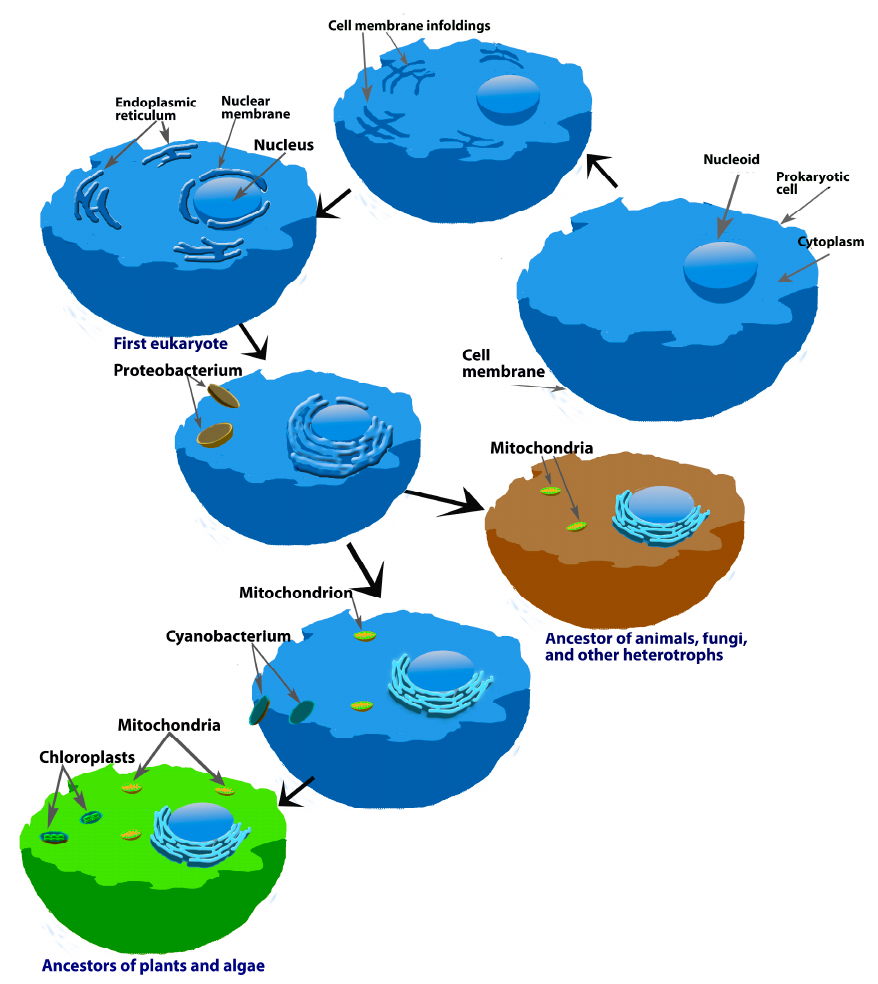
Figure 5. This is an illustration of what is referred to as the endosymbiotic theory for the origin of mitochondria (and chloroplasts) and why these organelles in present-day eukaryotes likely have the ability to produce melatonin. A couple of billion years ago, prokaryotes phagocytized proteobacteria, which are known to synthesize melatonin; these bacteria were initially digested and used as nutrition. During evolution, the ingested bacteria eventually developed a mutually-beneficial symbiotic relationship with the cells that ingested them and they evolved into mitochondria. When they did so, the evolved mitochondria retained the ability to produce melatonin (brown image). As a result, present-day eukaryotic cells synthesize melatonin as shown in several reports cited in the current review. Likewise, some of the same prokaryotes also engulfed photosynthetic, melatonin-producing bacteria which evolved into chloroplasts of plant cells (green image); chloroplasts also have been shown to be involved in melatonin synthesis. Since plant cells have both chloroplasts and mitochondria may explain why plants generally have higher cellular concentrations of melatonin than do animal cells, which only have mitochondria.